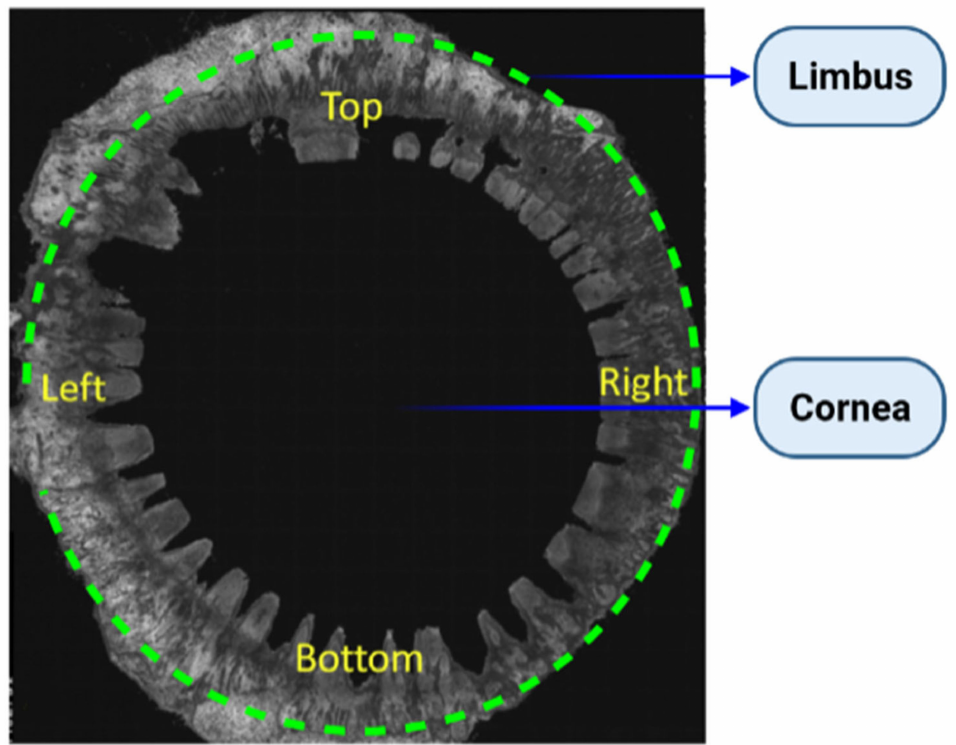
Figure 1. The morphology of the human limbal region for the entire eye. Entire 360 ◦ corneoscleral rim, where corneal button has been removed for keratoplasty. Image captured by OCT [6]. The adult conjunctiva is a lamellar tissue consisting of a stratified epithelium, an inner monolayer of the endothelium, with each cell form divided by a specialized membrane and a collagenous substantia propria (stroma) sparsely filled with keratocytes, Bowman’s layer Descemets and anterior membrane. The corneal epithelium is divided into three levels: b (basal), W (wing) and S (squames), as represented in Figure 2A,B. Matrix molecules secreted by b cells may be inserted into the BM (basement membrane) and stroma. W and